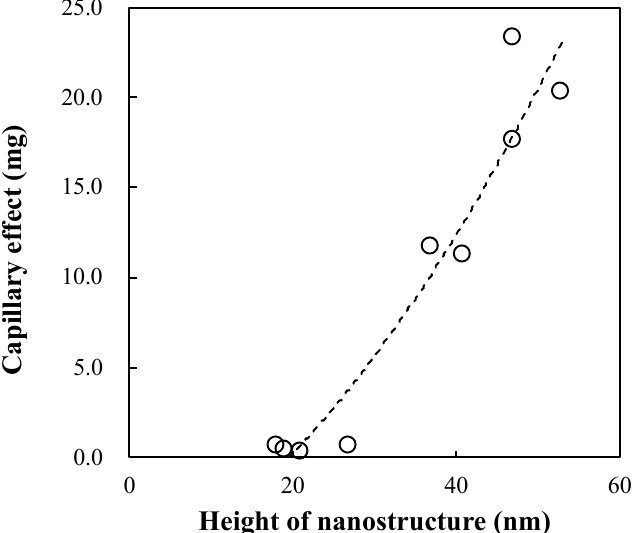
Figure 8. Relation between the capillary effect and the height of the nanotexture.